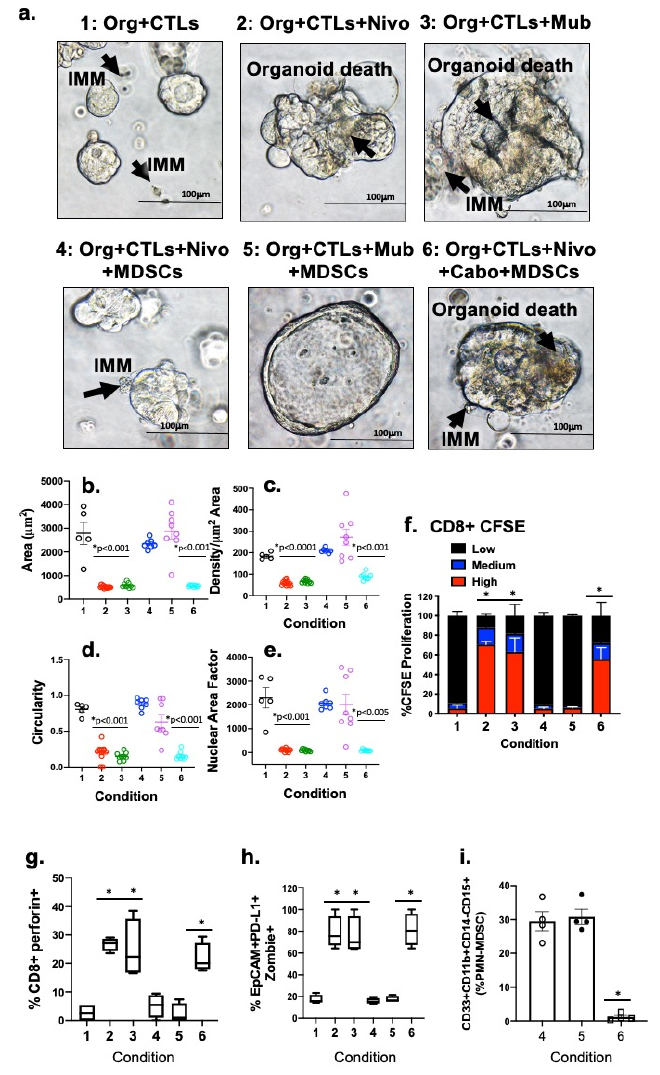
Figure 4. Depletion of PMN-MDSCs sensitizes PD-L1 + huTGO/immune cell (IMM) co-cultures to Nivolumab. ( a ) Morphological alterations of huTGOs 48 h after the in vitro vehicle (Control) treatment in co-culture with CTLs (Condition 1), Nivolumab (0.5 µ g/mL; Condition 2) or Mubritinib (6 nM; Condition 3); in co-cultures with CTLs, Nivolumab, and MDSCs (Condition 4) or CTLs, Mubritinib, and MDSCs (Condition 5); or Nivolumab and Cabozantinib together (10 µ M, Condition 6) in co-cultures with CTLs and MDSCs. Quantitative changes in ( b ) area ( c ) density ( d ) circularity and ( e ) nuclear area factor. ( f ) Quantitative changes of CTL proliferation by CFSE, shown as percent (%) determined from flow cytometry data. Changes in ( g ) expression of perforin in CTLs, ( h ) percentage of viable EpCAM+/PD-L1+ huTGOs and ( i ) PMN-MDSCs after the treatments in Conditions 4 to 6. * p < 0.05 compared to Condition 1, shown here are n = 4 representative examples out of a total of 11 analyzed huTGO/immune cell co-cultures. Scale bar = 100 µ